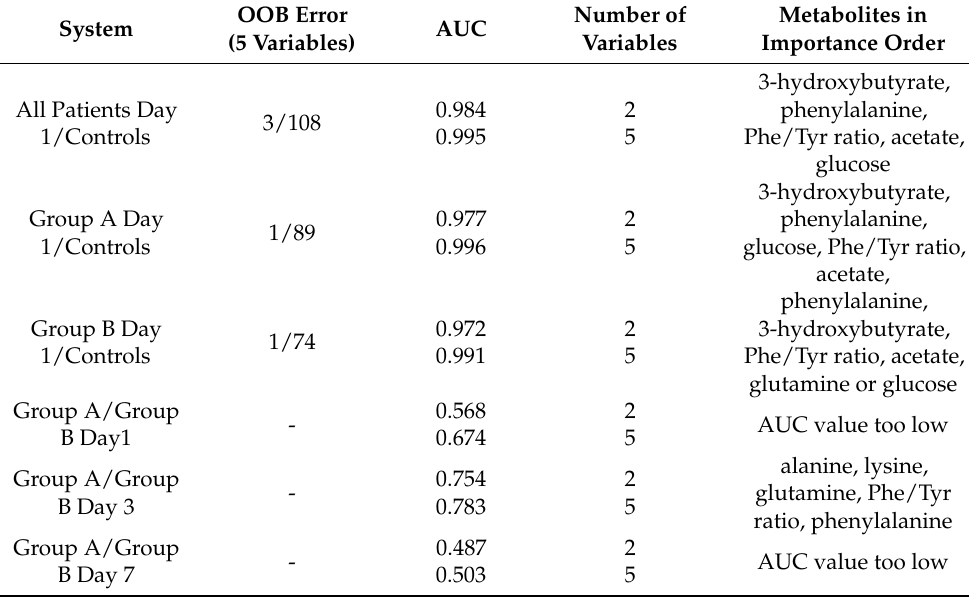
Table 3. Outputs from random forest discriminatory analyses for selected systems.